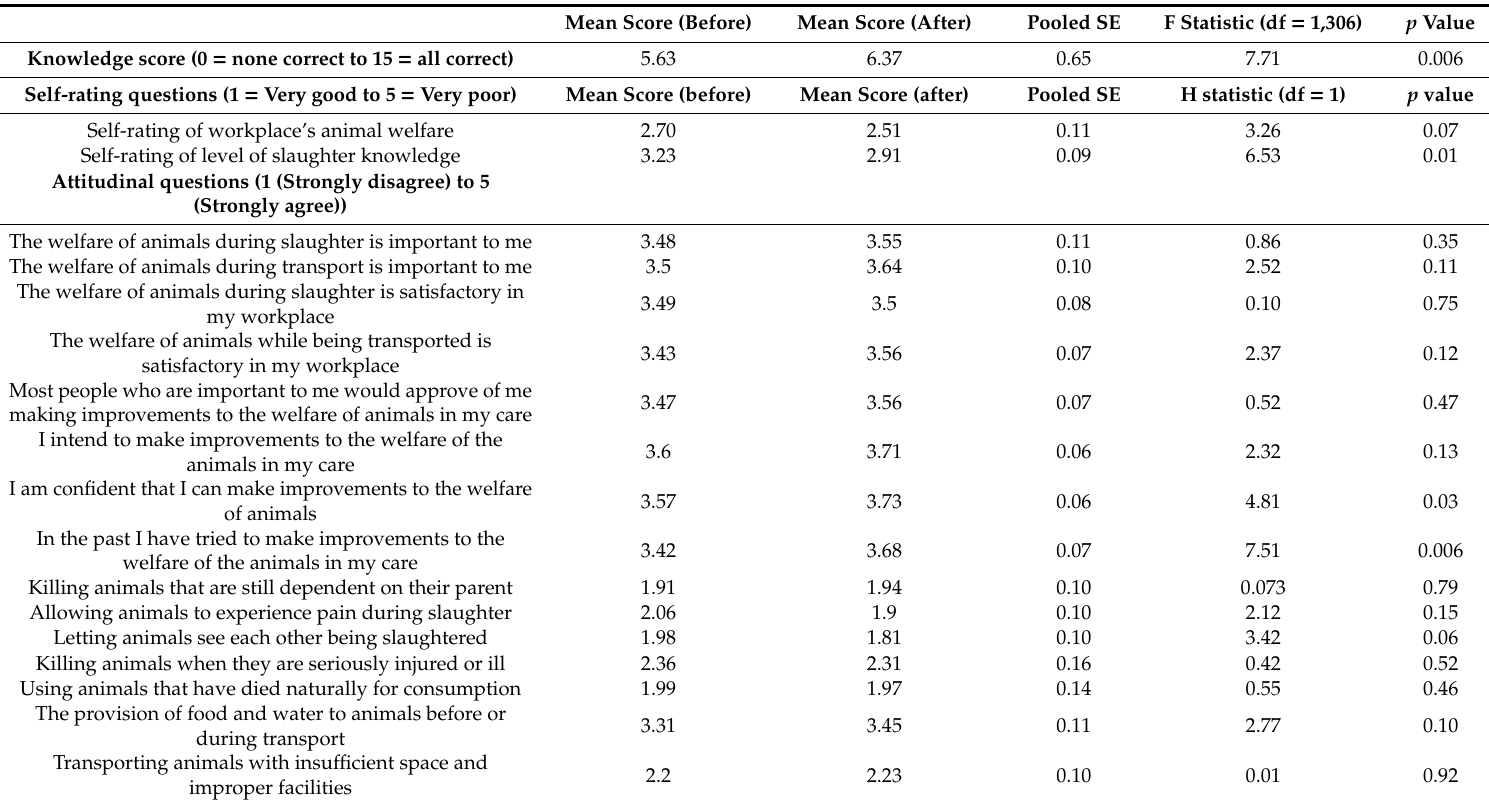
Table 2. Di ff erences in knowledge scores, self-rating, and mean attitude scores, before and after training. Mean Score (Before) Mean Score (After) Pooled SE F Statistic (df = 1,306) p Value Knowledge score (0 = none correct to 15 = all correct) 5.63 6.37 0.65 7.71 0.006 Self-rating questions (1 = Very good to 5 = Very poor) Mean Score (before) Mean Score (after) Pooled SE H statistic (df = 1) p value Self-rating of workplace’s animal welfare 2.70 2.51 0.11 3.26 0.07 Self-rating of level of slaughter knowledge